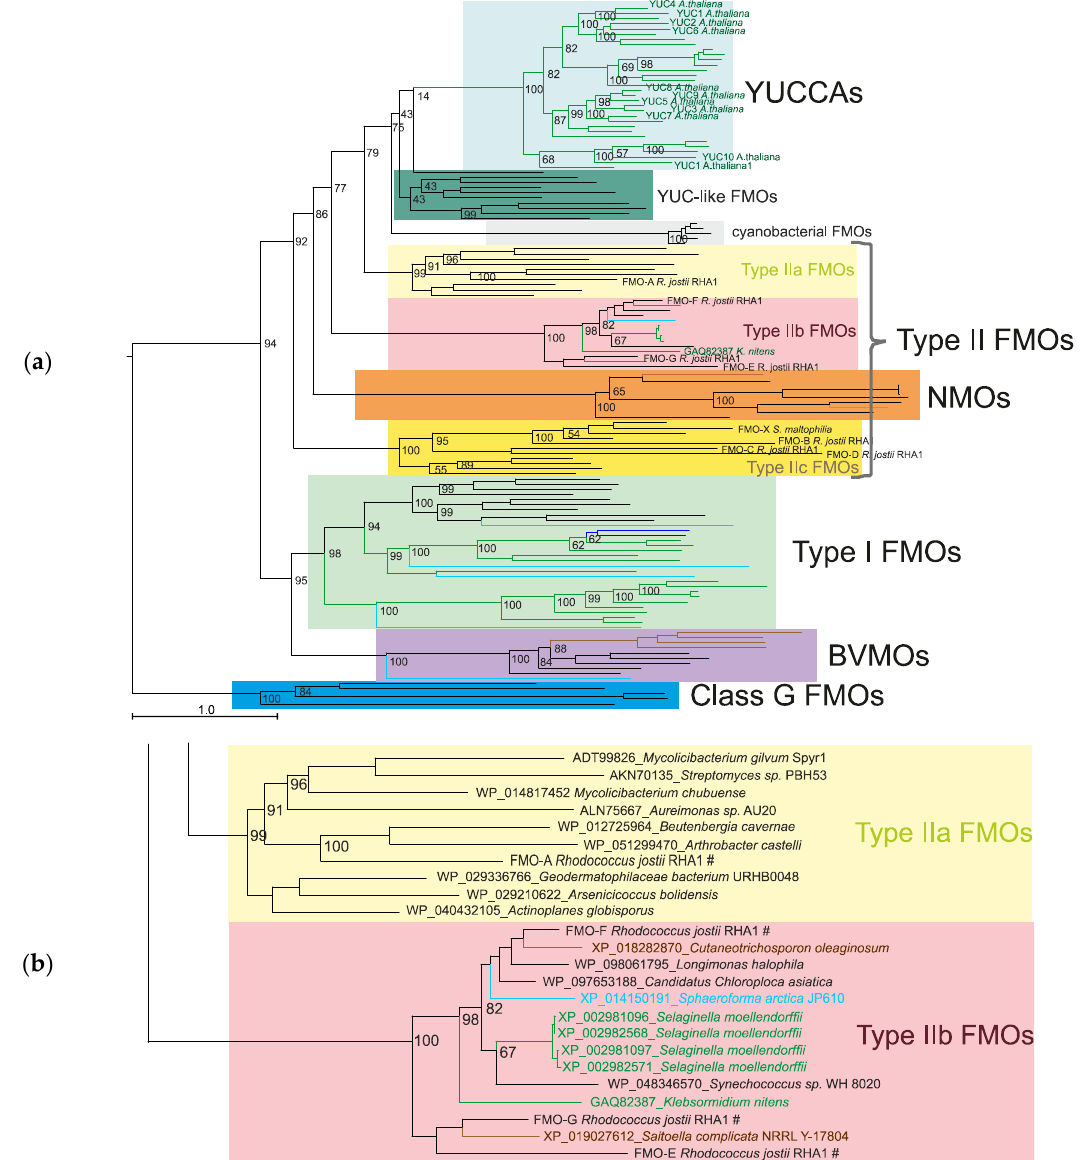
Figure 1. Phylogeny of the class B flavoprotein monooxygenases reconstructed using IQ-TREE. The branches of green alga and land plant proteins are green; of fungi, brown; of protists, cyan; of animals, blue; of bacteria, black; of archaebacteria, gray. ( a ) Phylogenetic tree of class B flavoprotein monooxygenases with the class G flavoprotein monooxygenases as an outgroup (dark blue background). ( b ) A fragment of the phylogenetic tree of class B flavoprotein monooxygenases comprising two groups of proteins: type IIa flavin-containing monooxygenases (FMOs) and type IIb FMOs; # denotes protein sequences from Riebel et al. [40]; the remaining designations are as in ( a ). The numbers near the branches represent bootstrap support values.